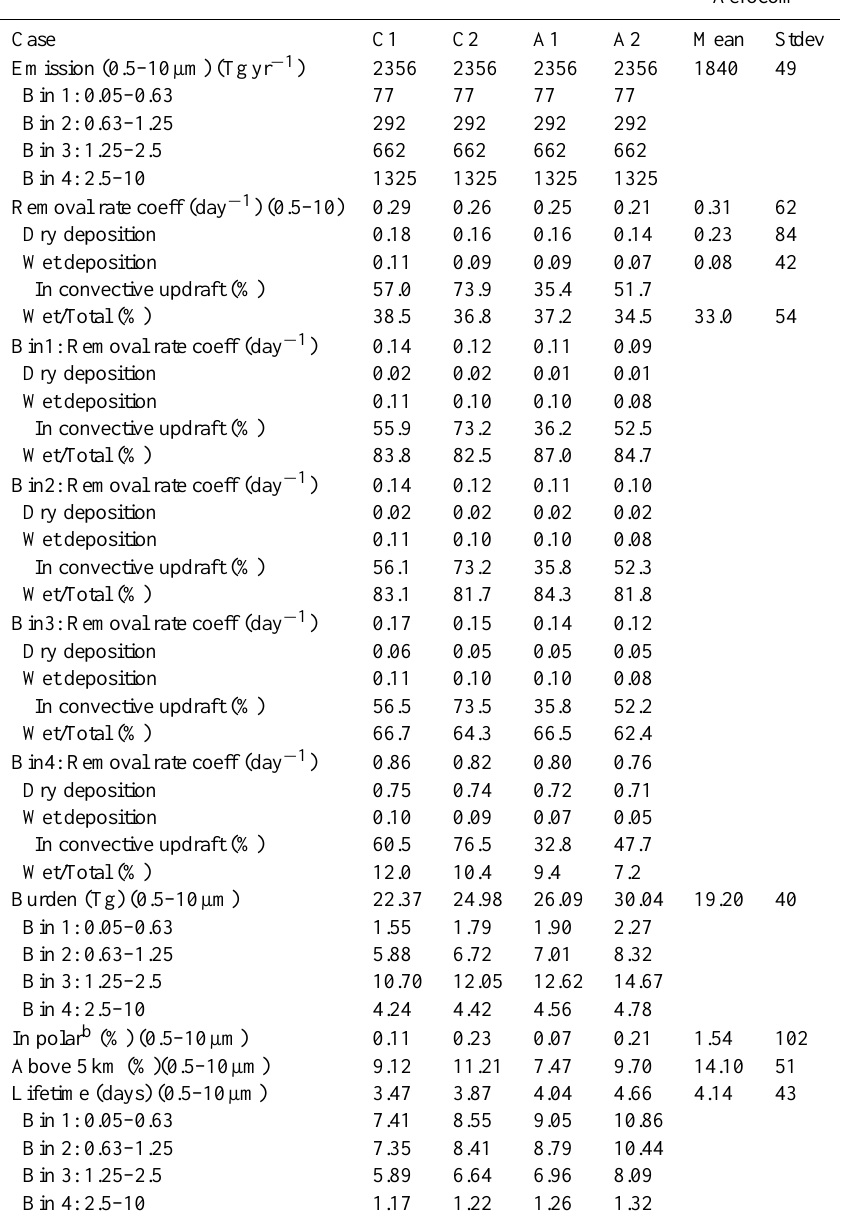
Table 6. Global budget of